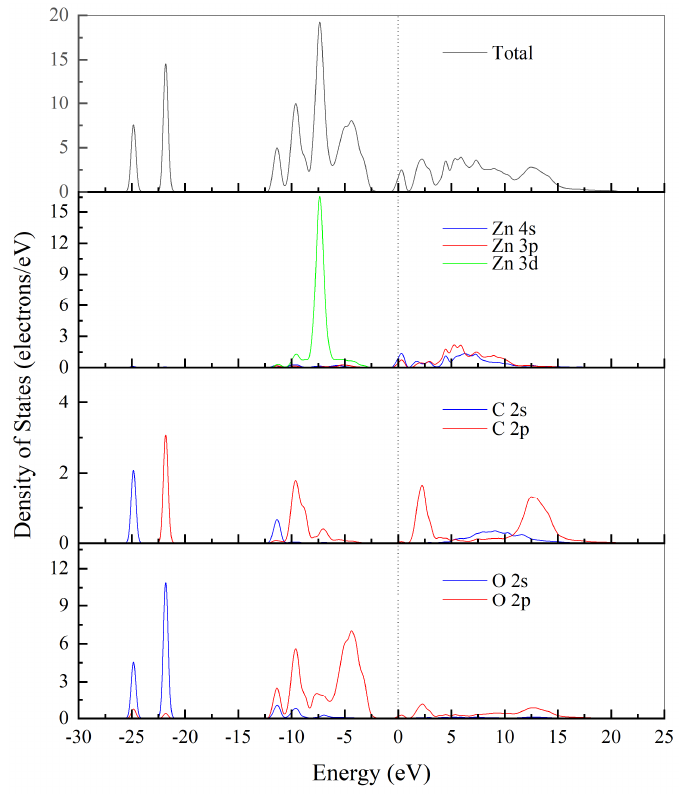
Figure 6. Calculated total and partial density of states of the atoms for the smithsonite (101) surface.